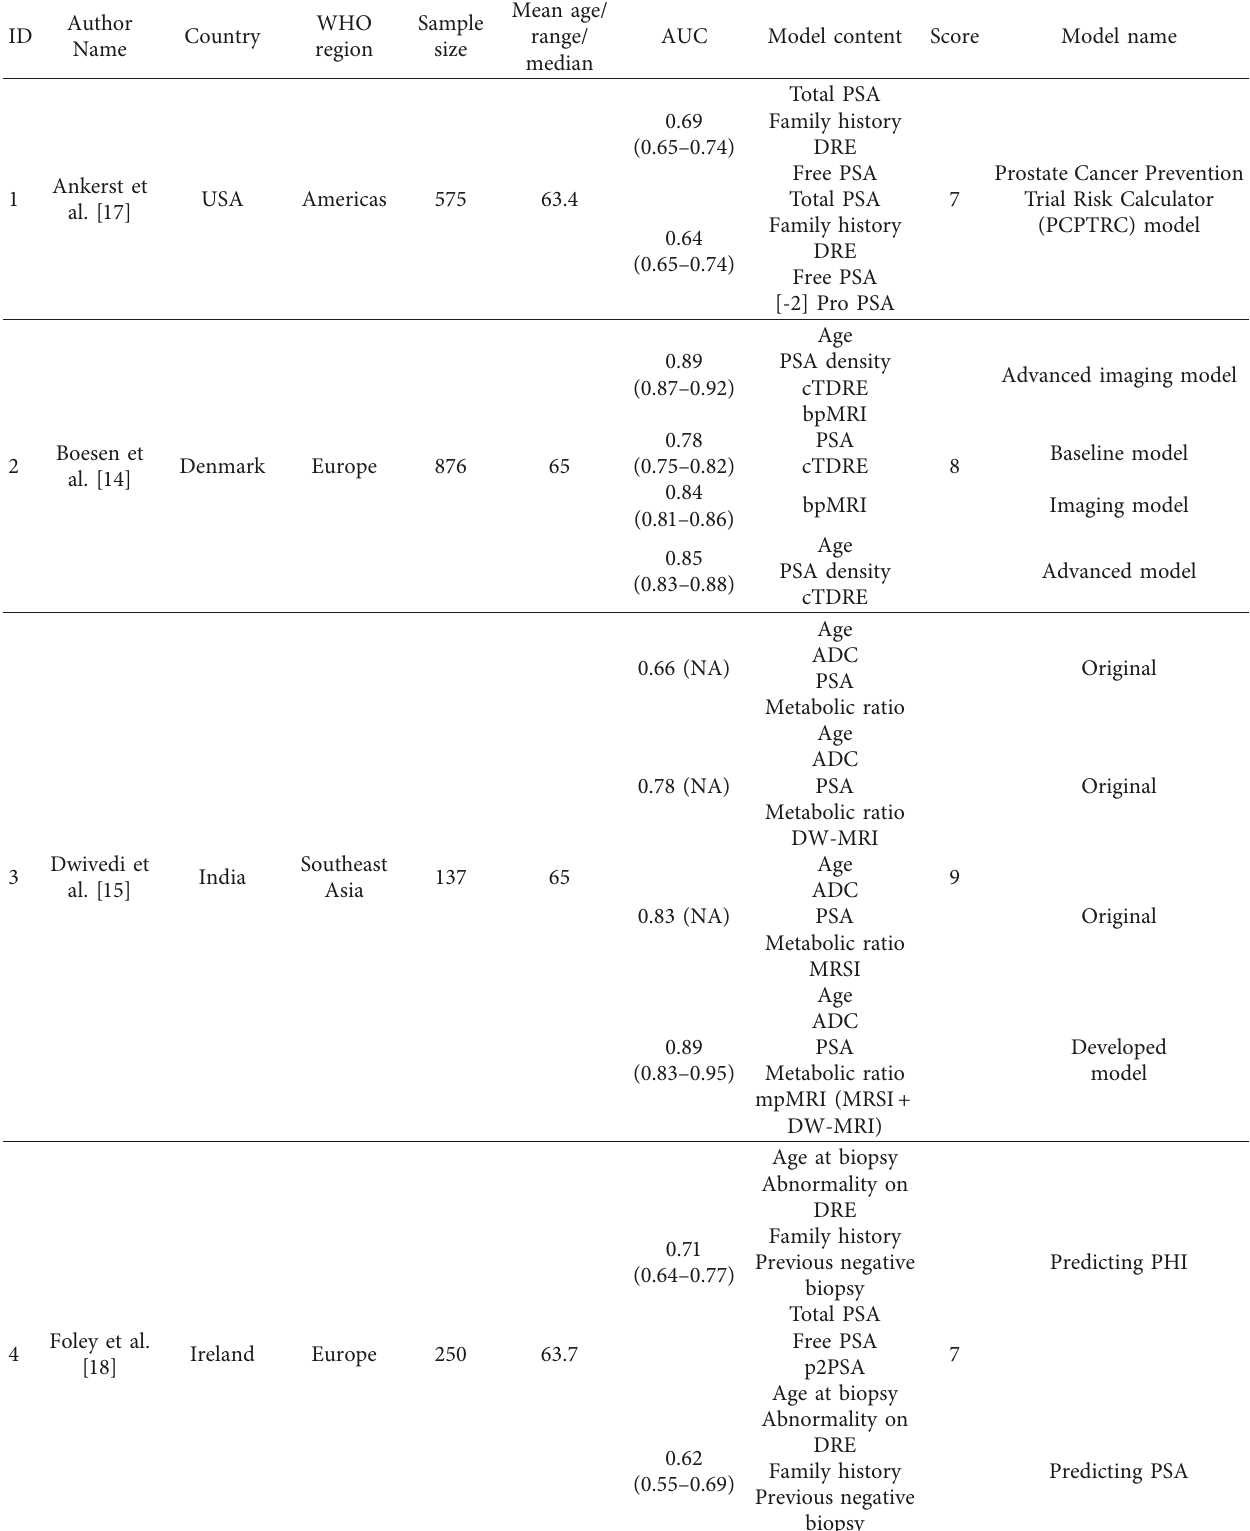
Table 1: Baseline characteristics for studies included in